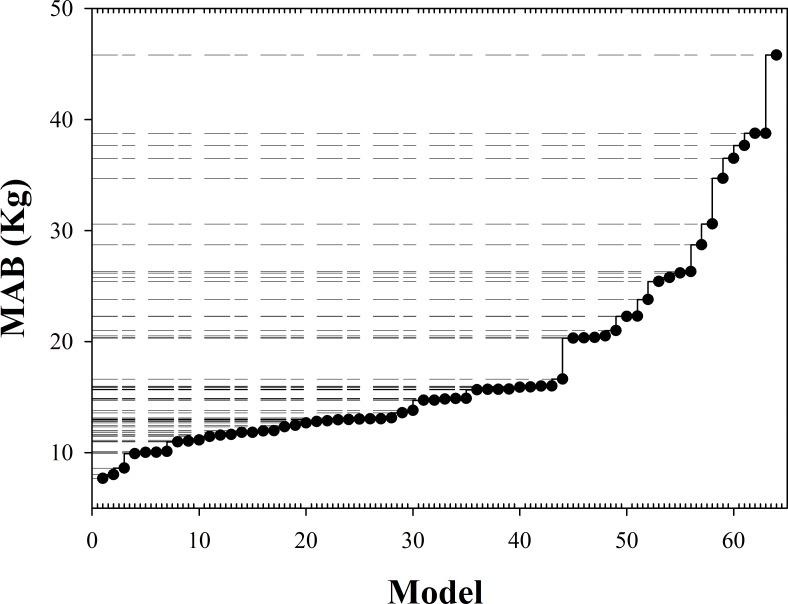
The MAB of 64 convergence biomass models in Table 2.